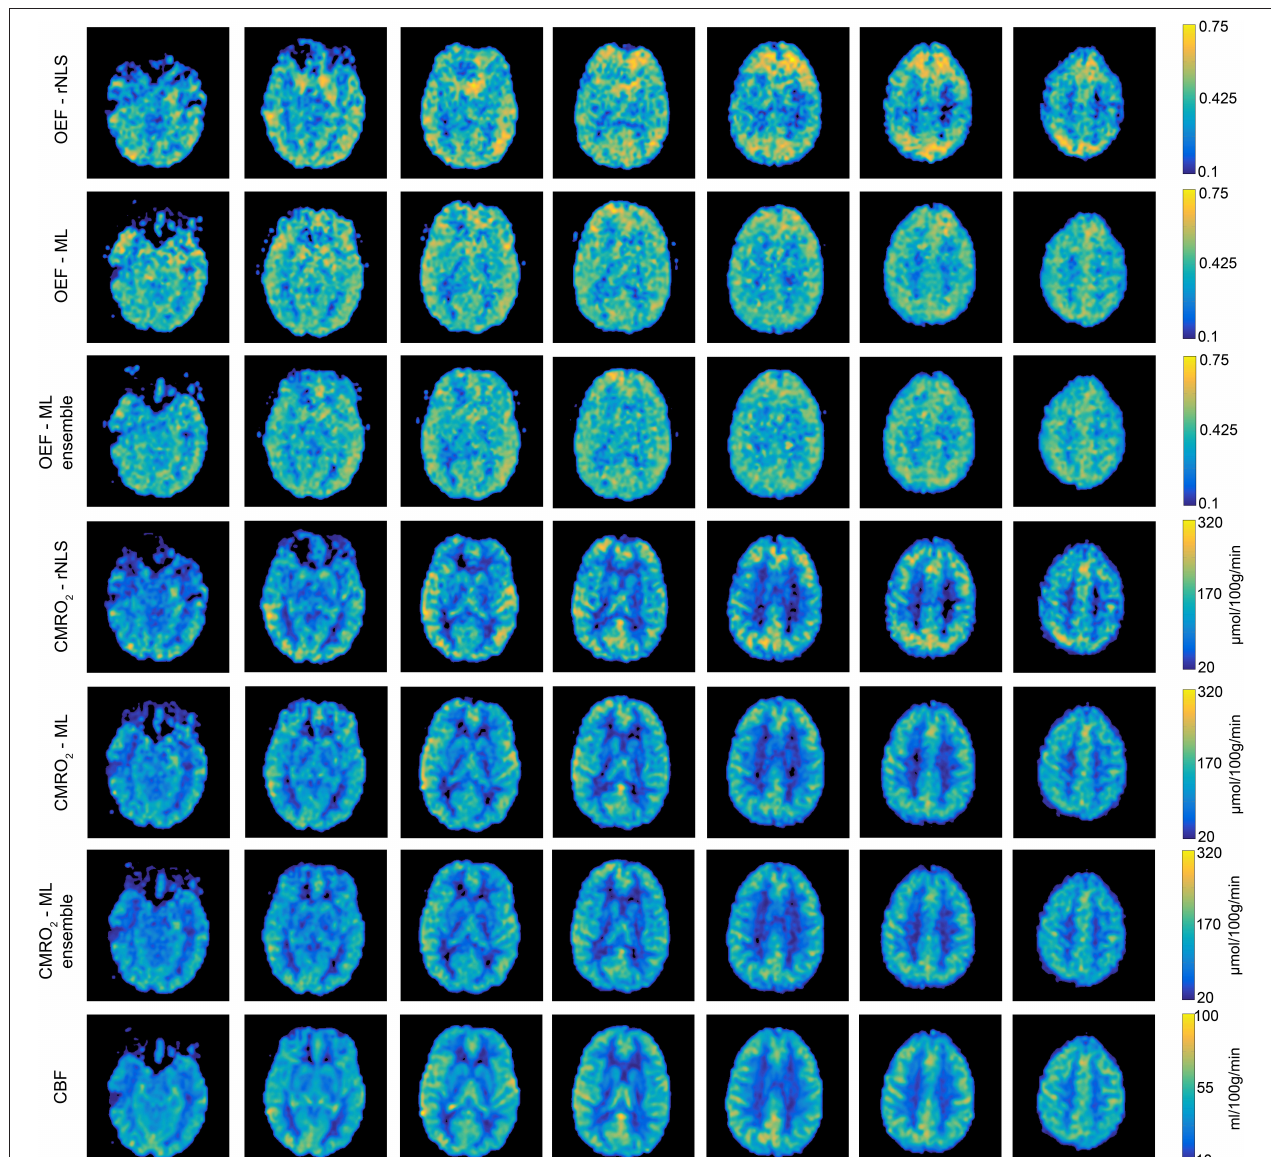
FIGURE 6 | Example parameter maps (CBF 0 , OEF 0 , and CMRO 2,0 ) from a single subject for each analysis method. Machine learning estimates of OEF 0 are more uniform than regularized non-linear least squares estimates. Using an ensemble of MLP networks further reduces the spatial variation in OEF 0